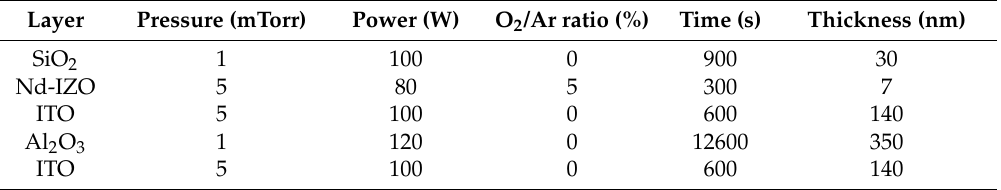
Figure 1. The cross-sectional image of the all sputtered Nd:IZO TFT with coplanar top-gate configuration. Figure 1. The cross ‐ sectional image of the all sputtered Nd:IZO TFT with coplanar top ‐ gate configuration. Table 1. The detailed sputtering conditions of each functional